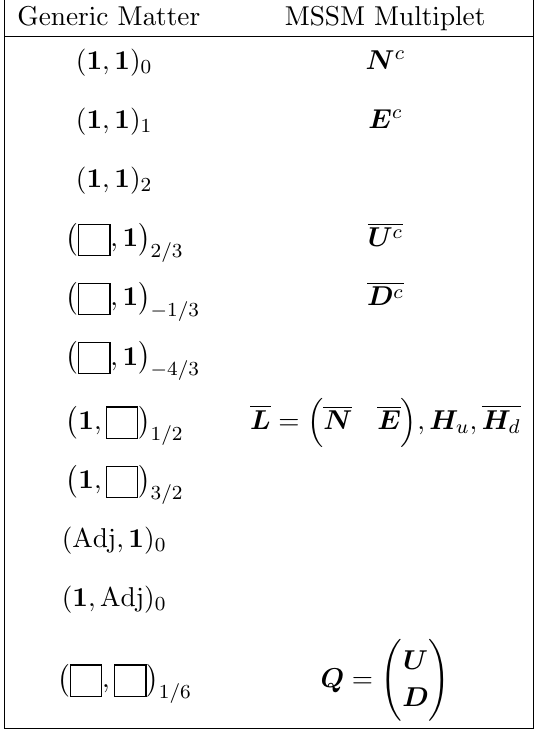
Table 5 . Generic matter representations (not including conjugates) for the gauge group SU(3) c (cid:2) SU(2) L (cid:2) U(1) Y = Z 6 , which include all the left-handed MSSM multiplets. The generic matter for the group SU(3) c (cid:2) SU(2) L (cid:2) U(1) Y does not include the MSSM multiplets. Furthermore, the only (cid:12)eld charged under both the SU(2) and U(1) charges ( 1